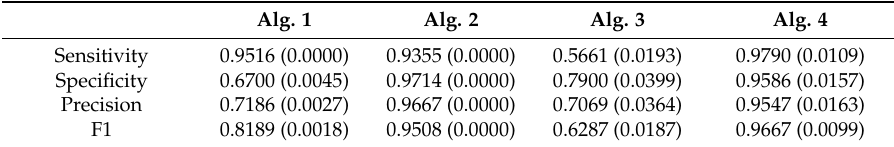
Table 8. A 10-fold cross-validation of the presented algorithms using the UMAFall dataset. The table shows the average values and the standard deviations in